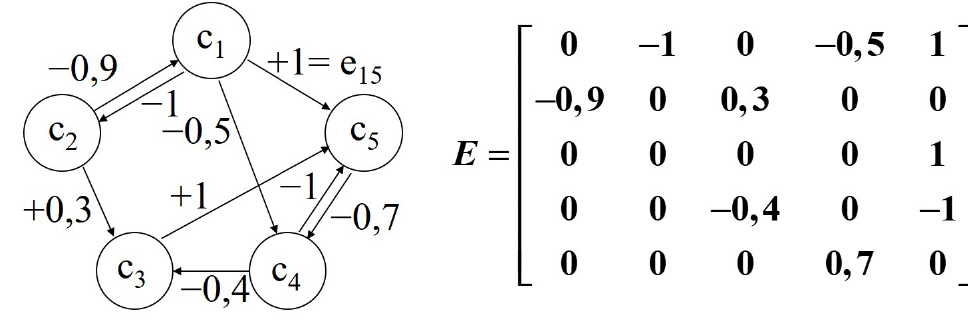
Figure 5. An illustrative example of an Fuzzy Cognitive Map (FCM) with its connection matrix E